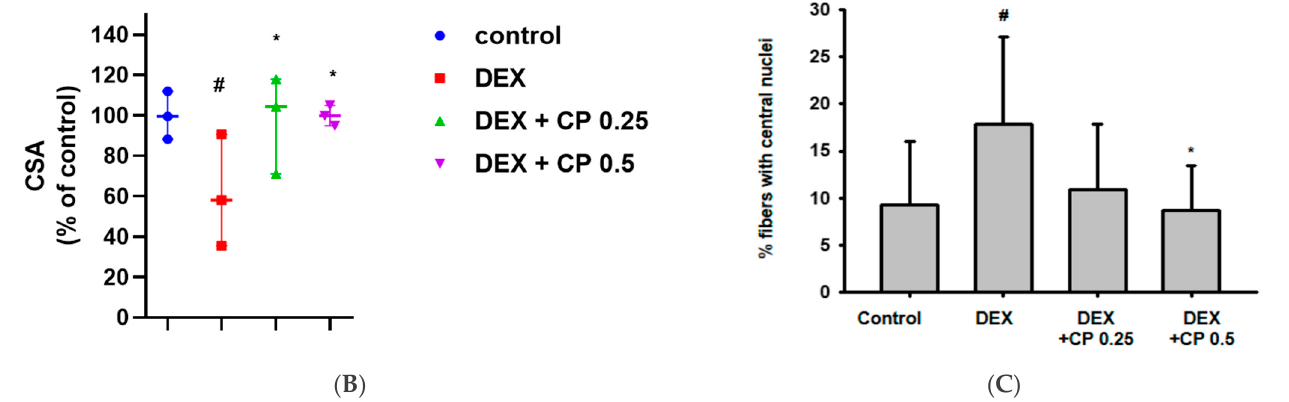
Figure 2. Effect of CP on histological features and cross-sectional area (CSA) of muscle fibers. ( A ) Representative H&E-stained images of calf muscles from each group. The arrow indicates a muscle fiber cell. Scale bar = 200 μ m. ( B ) CSA of calf muscle myofibers. Quantified data are presented as a relative percentage of the control. (C) Quantification of fibers with centrally located nuclei. The data in ( B , C ) are presented as the means ± SD. This experiment was performed with ten mice per group. # p < 0.05, DEX vs. control. * p < 0.05, DEX + CP (0.25 or 0.5) vs. DEX; CP, collagen peptides; DEX, dexamethasone.